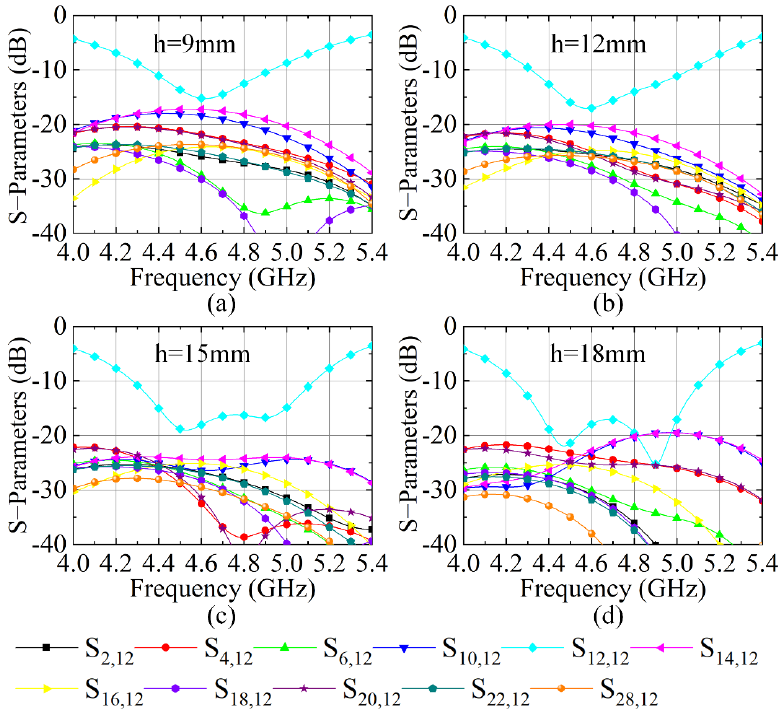
Figure 7. S-parameter of the antenna array loading with the proposed NRMS with different h, ( a ) h = 9 mm, ( b ) h = 12 mm, ( c ) h = 15 mm, and ( d ) h = 18 mm.